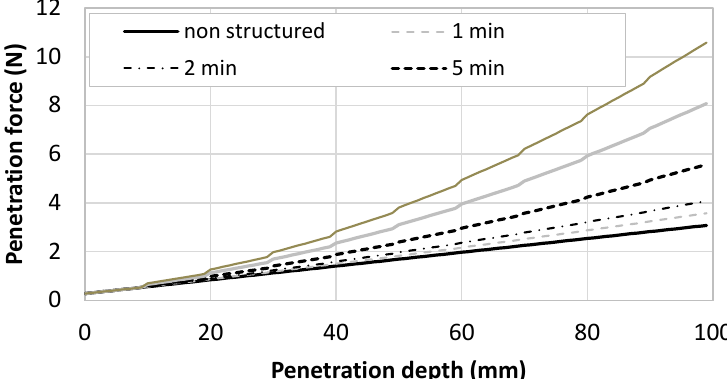
Figure 5. Penetration force evolution of nails (D = 3 mm) within a layered printed structure of Mortar 1 with different time gap ranging from 1 to 15 min.